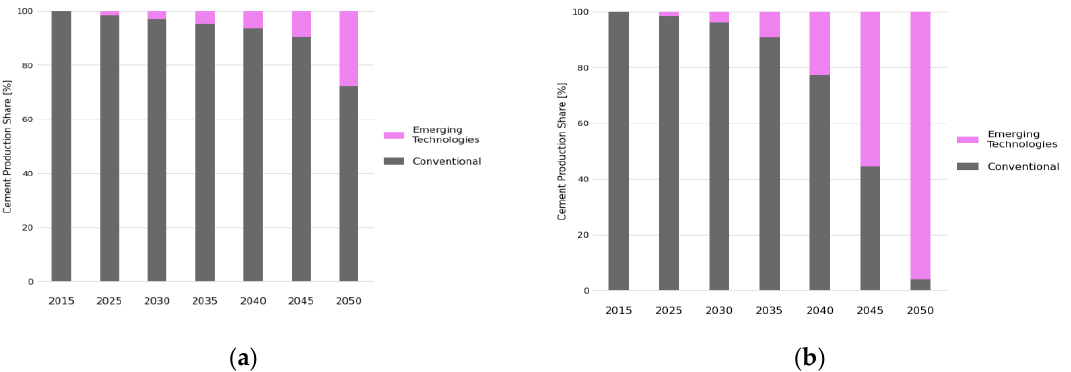
Figure 12. Australia’s cement production technology mix over time for different scenarios: ( a ) LME; ( b ) P1.5 °C. Table1. Impactsofdi ff erentscenariosforAustralia’senergy-relatedCO 2